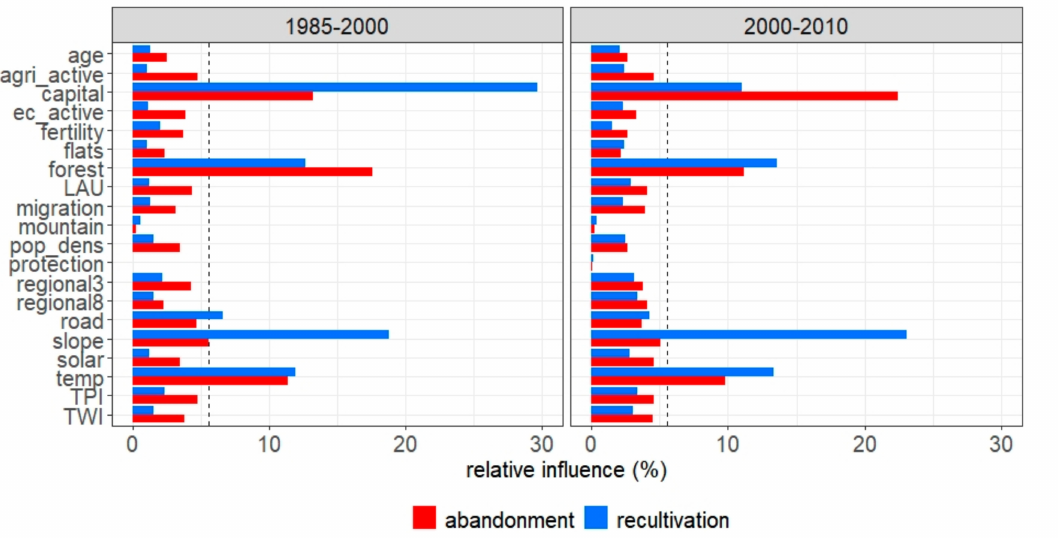
Figure 5. Relative influence of variables used to model agricultural abandonment, and recultivation. The dashed line indicates the threshold used to consider variables as meaningful for